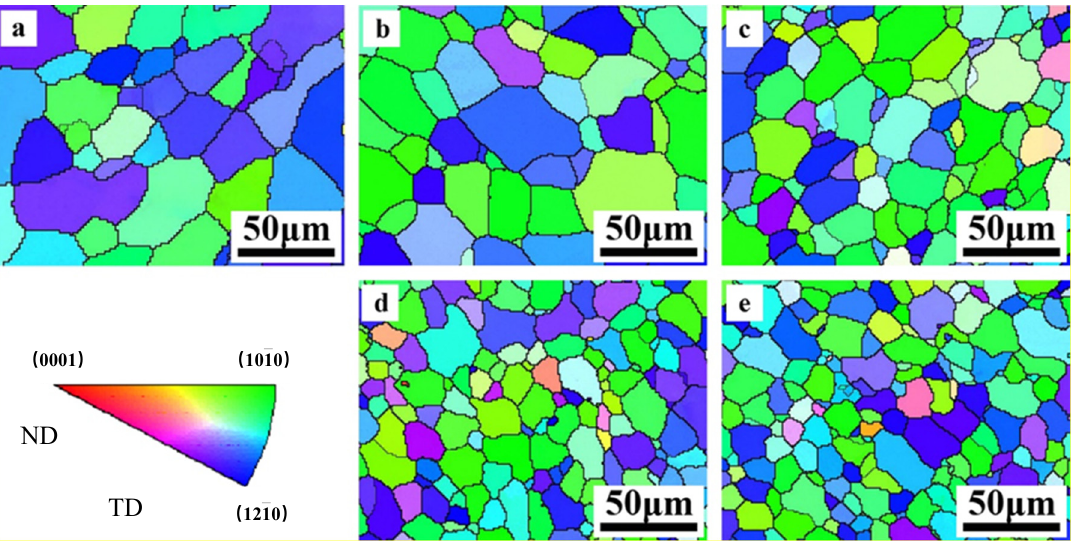
Figure 6. EBSD of as-extruded Mg–Al alloy ( a ) Mg, ( b ) Mg–1Al, ( c ) Mg–2Al, ( d ) Mg–3Al, ( e ) Mg–4Al. Figure 7 is pole figures to show the texture of the cross-sectional as-extruded alloys measured by XRD. Most hcp materials present a basal texture around the extrusion axis which is developed during uni-axial deformation, and it is also commonly observed after round extrusion of wrought magnesium alloys. Mg and Mg–Al alloys show a typical ring fiber texture according to the graphs. The maximum value of texture intensities of Mg–xAl (x = 0, 2, 4) alloys are 4.2 multiples of random distribution (m.r.d), 3.1 m.r.d, 3.1 m.r.d, respectively. Coinciding with EBSD analysis, it indicates that the addition of